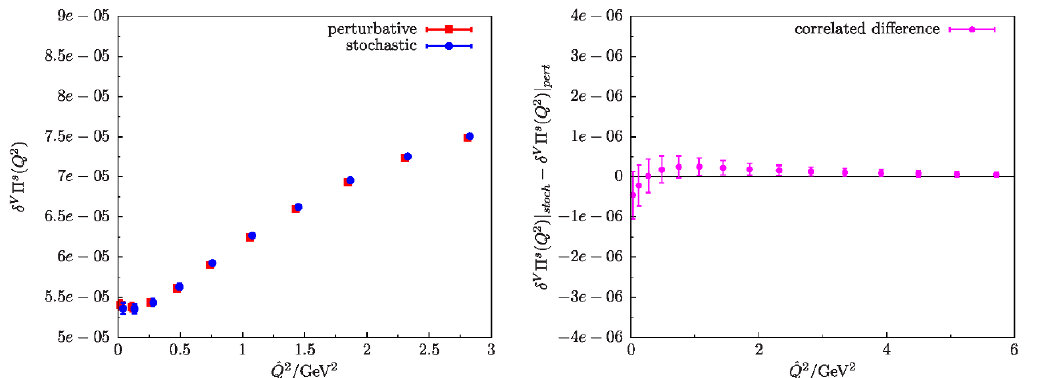
Figure 10 . The QED correction (cid:14) V (cid:5)( ^ Q 2 ) to the HVP form factor for the up quark. The plot on the left shows results from the stochastic method (blue circles) and the perturbative method (red squares). The plot on the left shows the correlated di(cid:11)erence between stochastic and pertur- bative data.